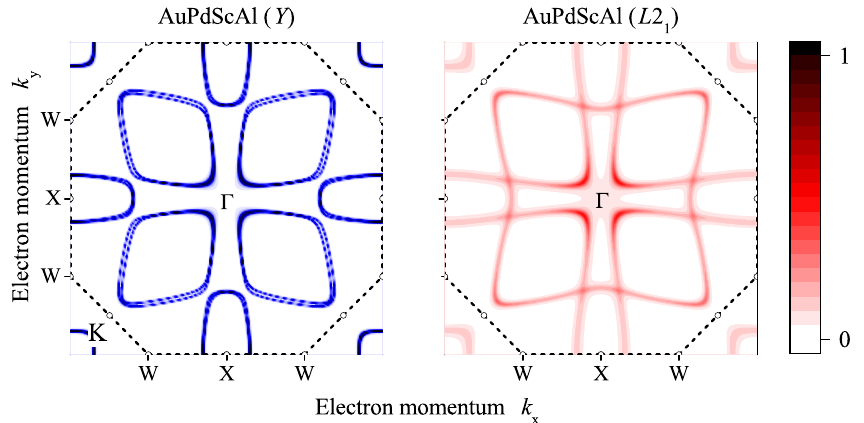
Figure 9. Fermi surface of ordered and disordered AuPdScAl. Comparison of Bloch spectral functions in the xy plane of AuPdScAl in the Y and L 2 1 structures. The border of the first Brillouin zone is indicated by the dashed line with open symbols at the positions of the high symmetry points. The colour scale bar is normalized to